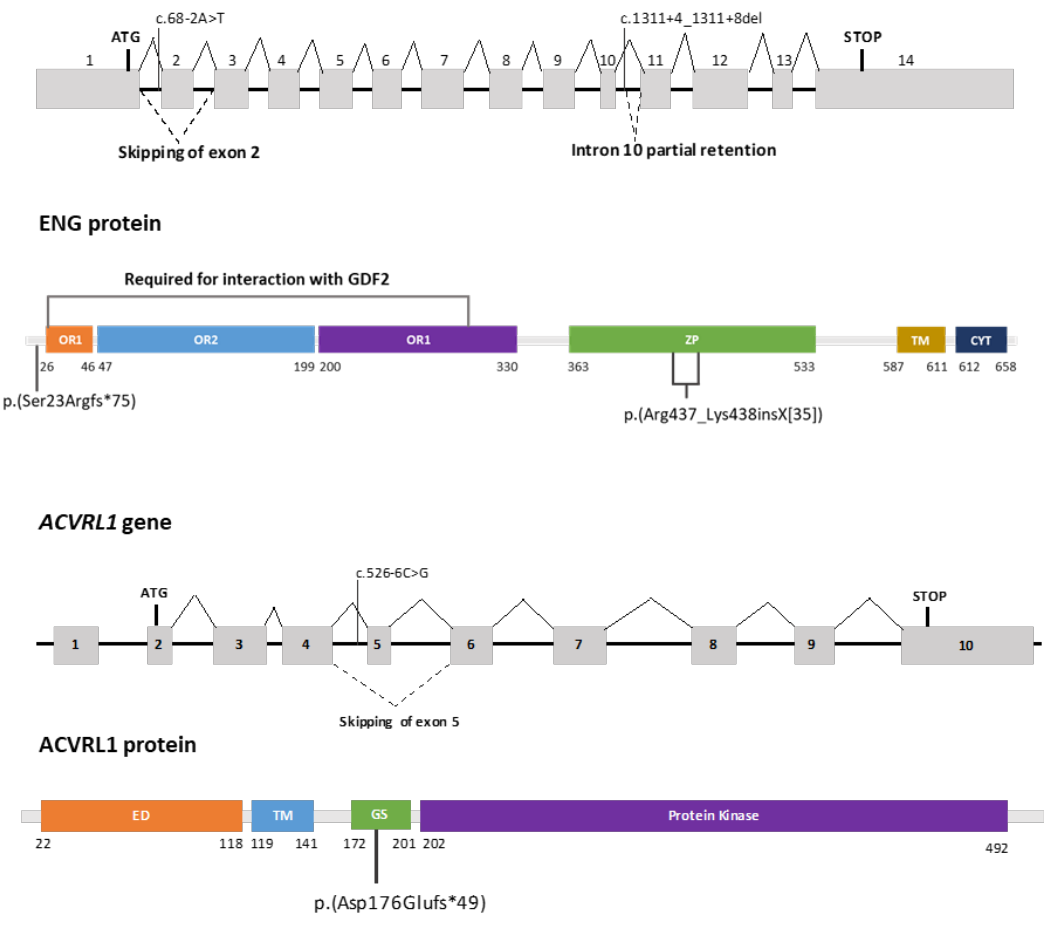
Figure 2. Schematic structure of ENG (NM_001114753.3, NP_001108225.1) and ACVRL1 (NM_000020.3, NP_000011.2) genes illustrating the predicted variant effect on splicing and protein. ( a ) Predicted effect of the variants identified in ENG gene. The variant c.68-2A > T would lead to exon 2 skipping and is predicted to introduce a frameshift with a premature stop codon at the protein level. The variant c.1311+4_1311+8del induces a partial intron 10 retentions introducing 35 amino acids in the protein sequence. ( b ) The variant c.526-6C > G identified in the ACVRL1 gene would lead to exon 5 skipping and the introduction of a frameshift with a premature stop codon at the protein level. Exons are shown as boxes and introns as lines. Protein functional domains are shown as boxes. The variants are indicated with vertical lines and the amino acid insertion is delimited by gray lines. Orphan domain (OR), Zona Pelucida domain (ZP), Transmembrane domain (TM), Cytoplasmic domain (CYT), Extracellular domain (ED), Glycine and Serine rich region (GS).